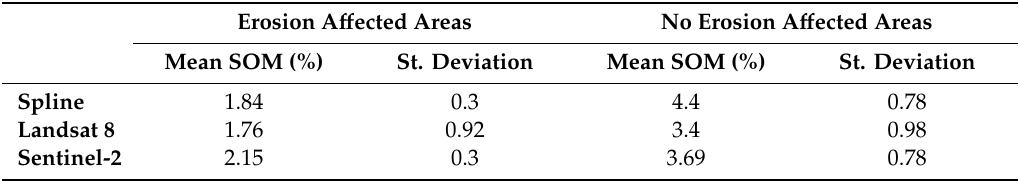
Table 5. Statistical results of SOM and the RUSLE correlation